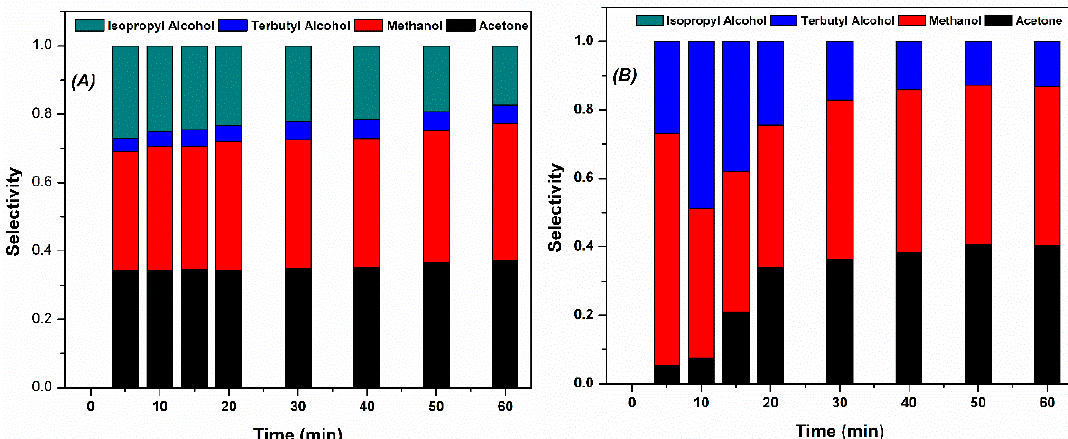
Figure 7. Selectivity of the products identified in the MTBE oxidation reaction. Highly dispersed catalyst ( A ), low dispersed catalyst ( B ). Table 4. Catalytic activity based on by-products.